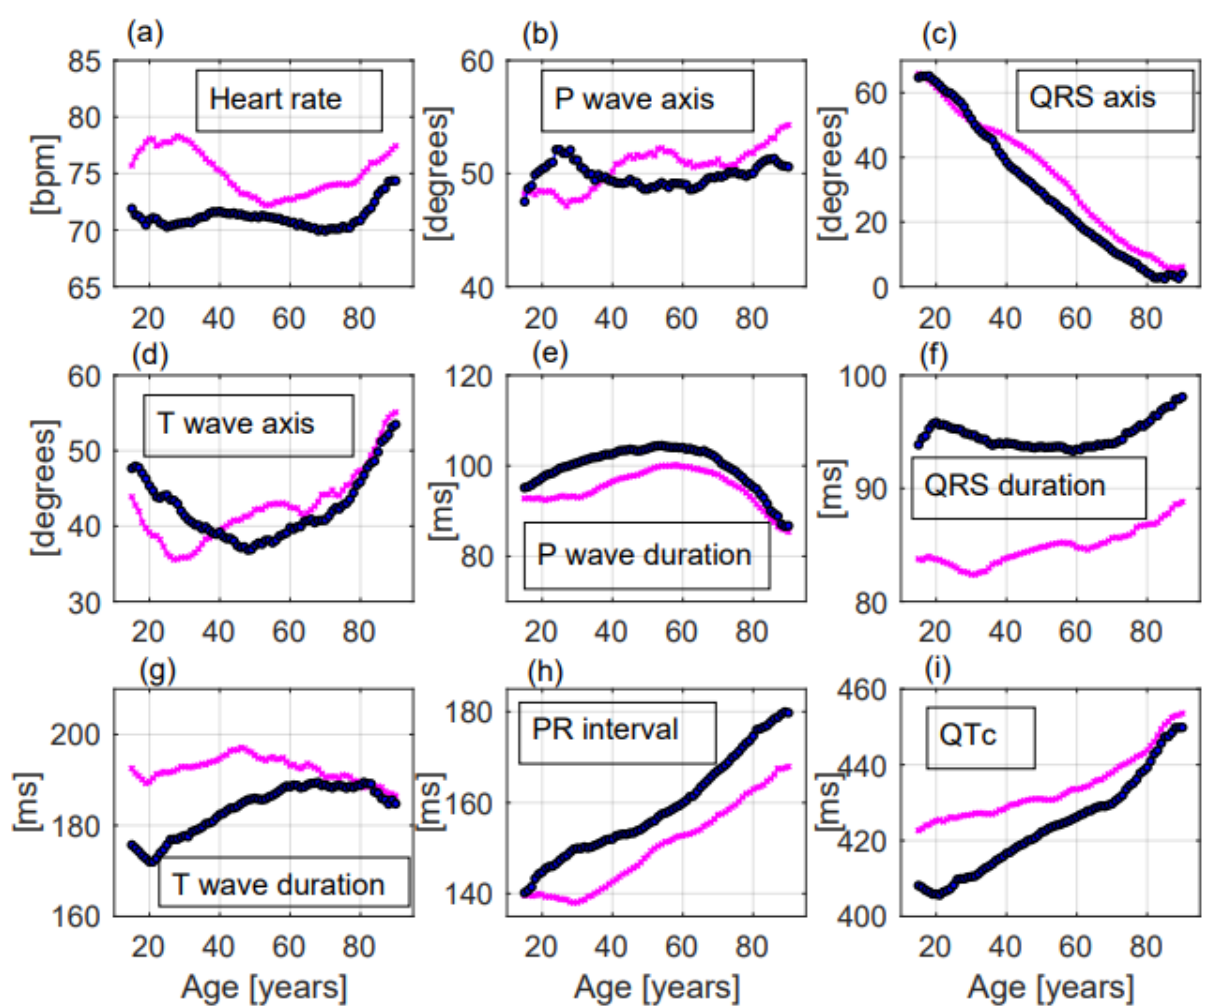
Figure 3. ECG changes with ageing of the considered parameters in females — and in males — . Significant differences between females and males were observed for most of the ECG parameters ( a – i ). Especially heart rate and QTc were significantly greater in females ( a , i ) while QRS duration and PR interval were significantly greater in males ( f , h ).